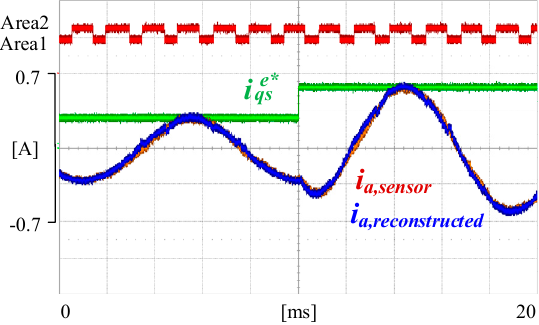
Figure 16. Step response of the real and estimated q-axis current.